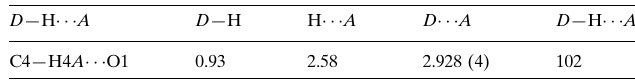
Hydrogen-bond geometry (A˚ , (cid:1)